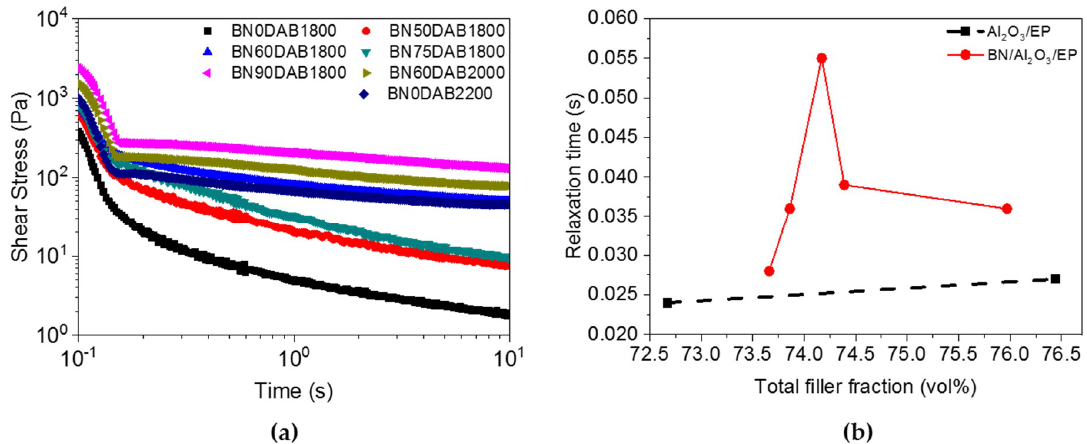
Figure 4. Stress relaxation data ( a ) and relaxation time versus total filler volume fraction of Al 2 O 3 /EP and BN/Al 2 O 3 /EP ( b ).